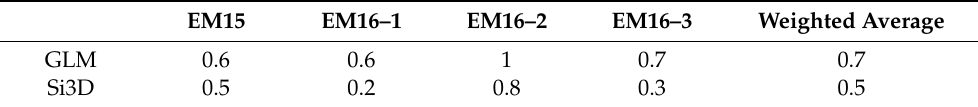
Table 8. The NMAEs of the temperature and DO of the 3-D model at FCR20, FCR30 and FCR45 for the 2014 simulation.